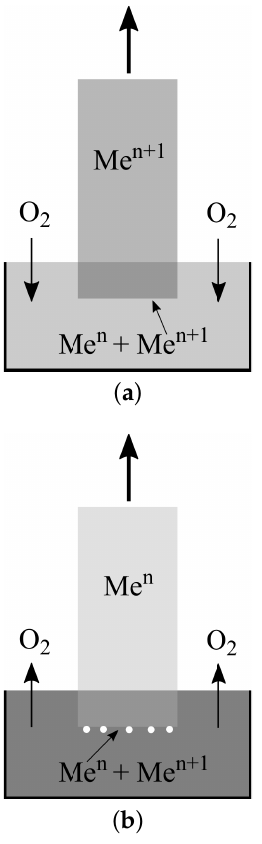
Figure 5. Growth of a metal oxide crystal with integer valence of the metal Me from a melt with different valences, Me n and Me n + 1 . A darker color means a higher oxidation level. ( a ) The crystal contains the higher valence ( n + 1 ) and only Me n + 1 is incorporated from the melt. The melt depletion by this ion must be compensated by the oxidation of Me n ions. ( b ) The crystal contains the lower valence ( n ) and only Me n is incorporated from the melt. The melt depletion by this ion must be compensated by a reduction in Me n + 1 ions, under the production of free oxygen. This will occur preferably at the crystallization front, and can lead there to bubbles (white